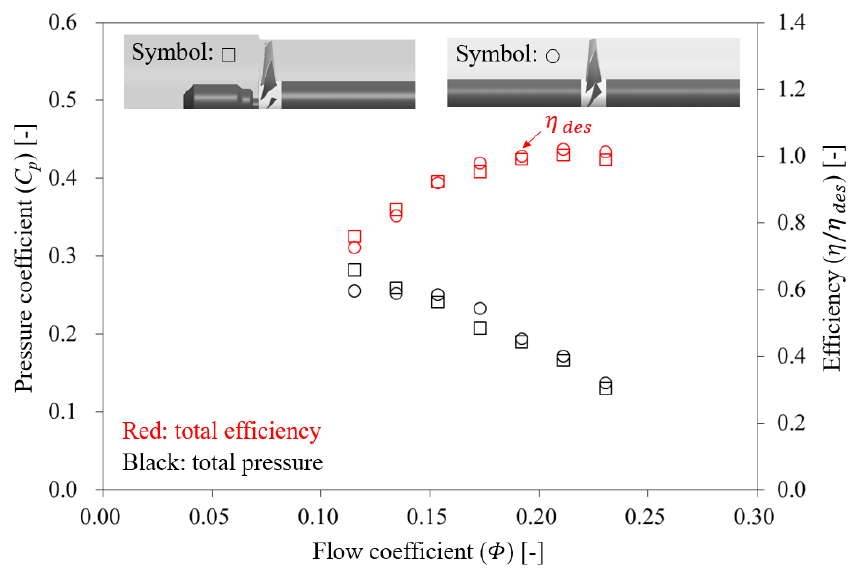
Figure 7. Performance curve for the influence of the inlet motor: square (inlet motor); circle (straight flow passage).